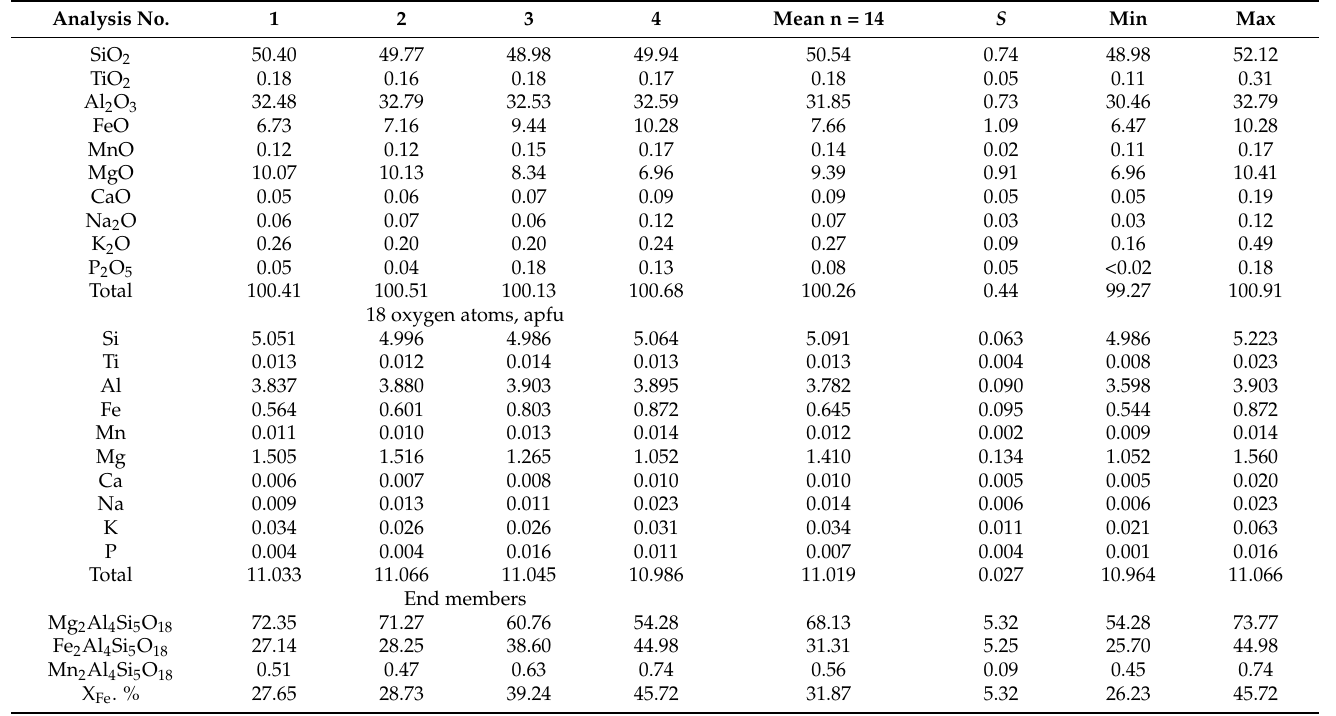
Table 6. Mineral chemistry of Fe-enrich cordierite from combustion metamorphic rocks of Karabetova Gora MV. Representative and average compositions. EPMA data (in wt%).